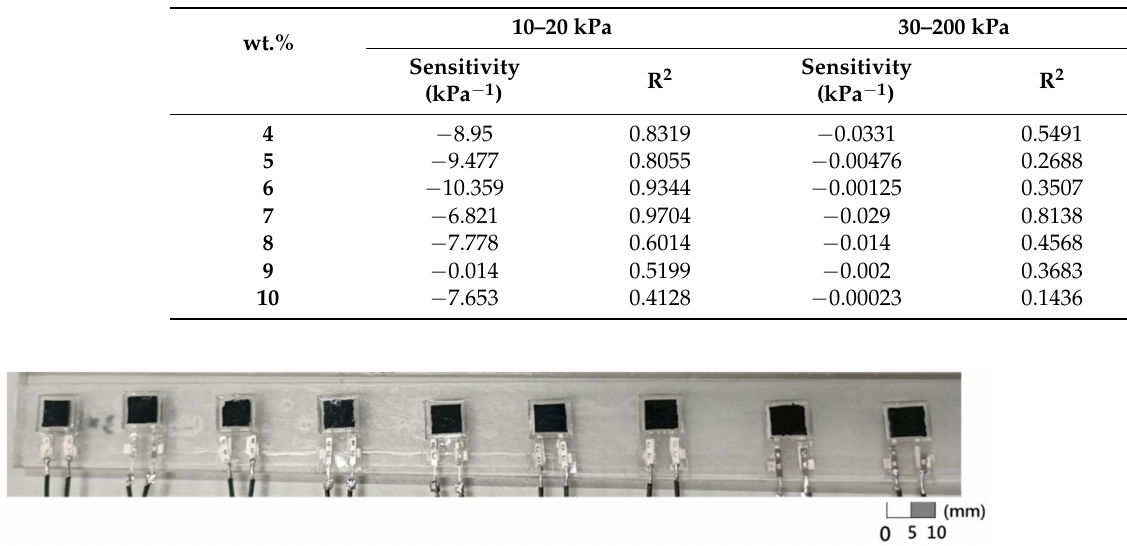
Table 4. Linear regression analysis of different MWCNT wt.% sensors.